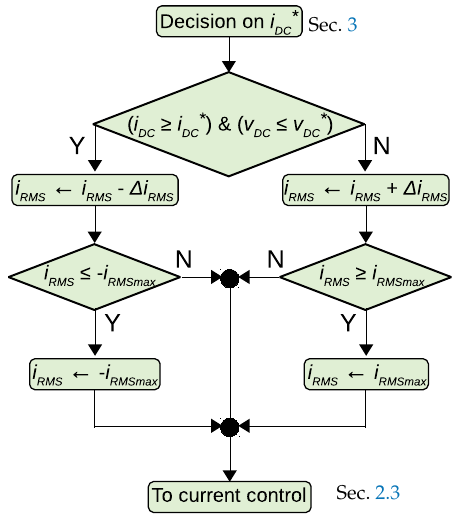
Figure 3. Algorithm for battery